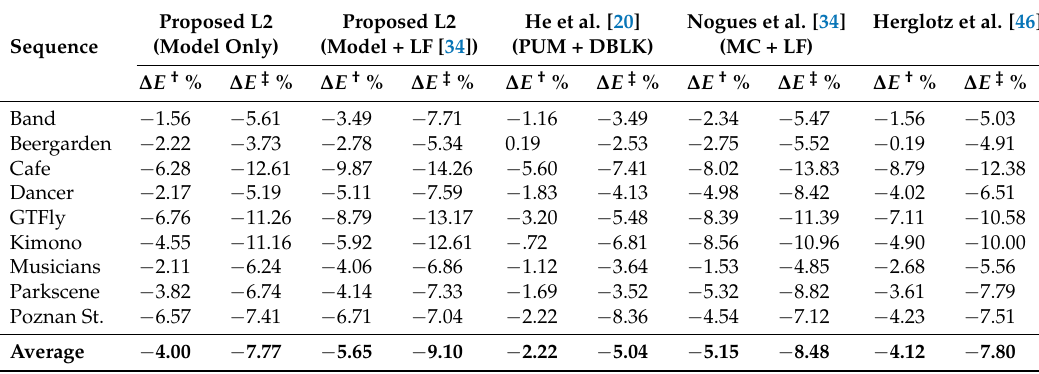
Table 4. Energy reduction performance during video streaming.